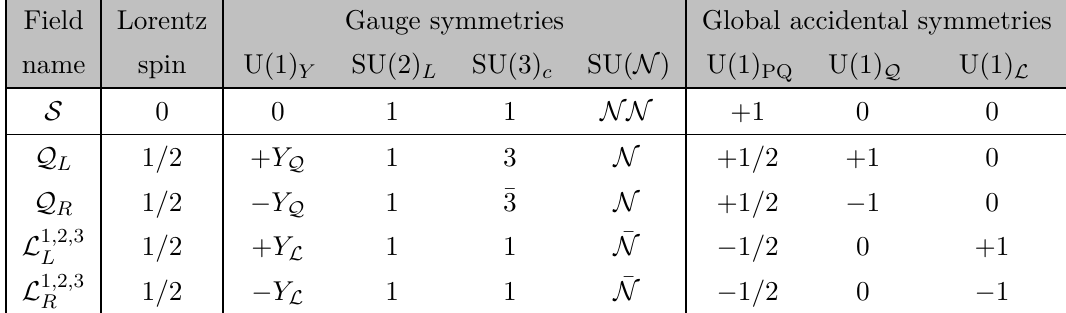
Table 1 . Field content of the model. The scalar S can be in the anti-symmetric (section 3) or in the symmetric (section 4) two-index representation. The heavy quarks Q L , Q R and leptons L L , L R are Weyl doublets. If L have vanishing hypercharge, their bound states could become acceptable DM candidates and there is no difference between L L and L R